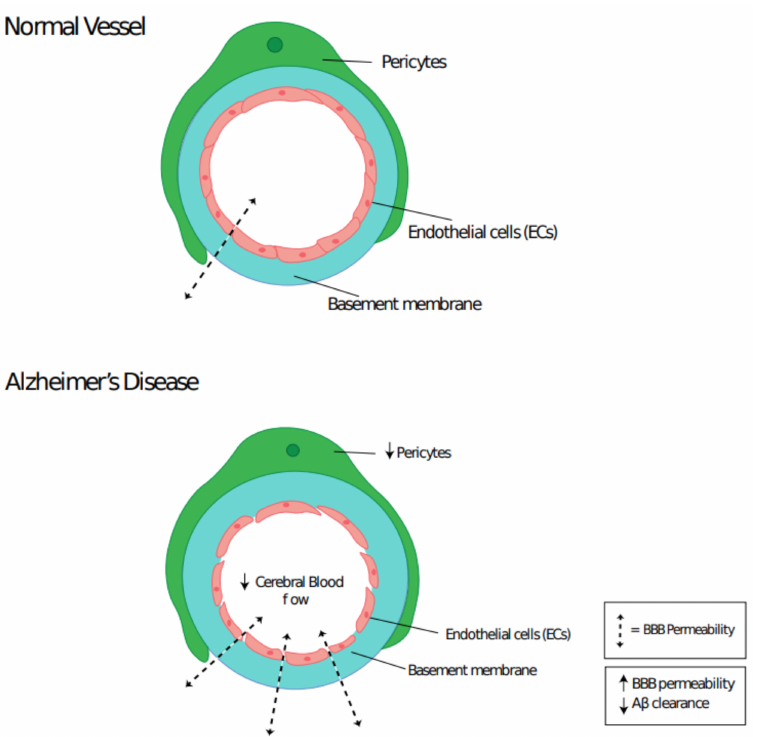
Figure 3. Cerebral capillary integrity is reduced in Alzheimer’s Disease pathogenesis. Pericyte loss leads to a drop in cerebral blood flow and increased blood–brain barrier permeability, which results in A β